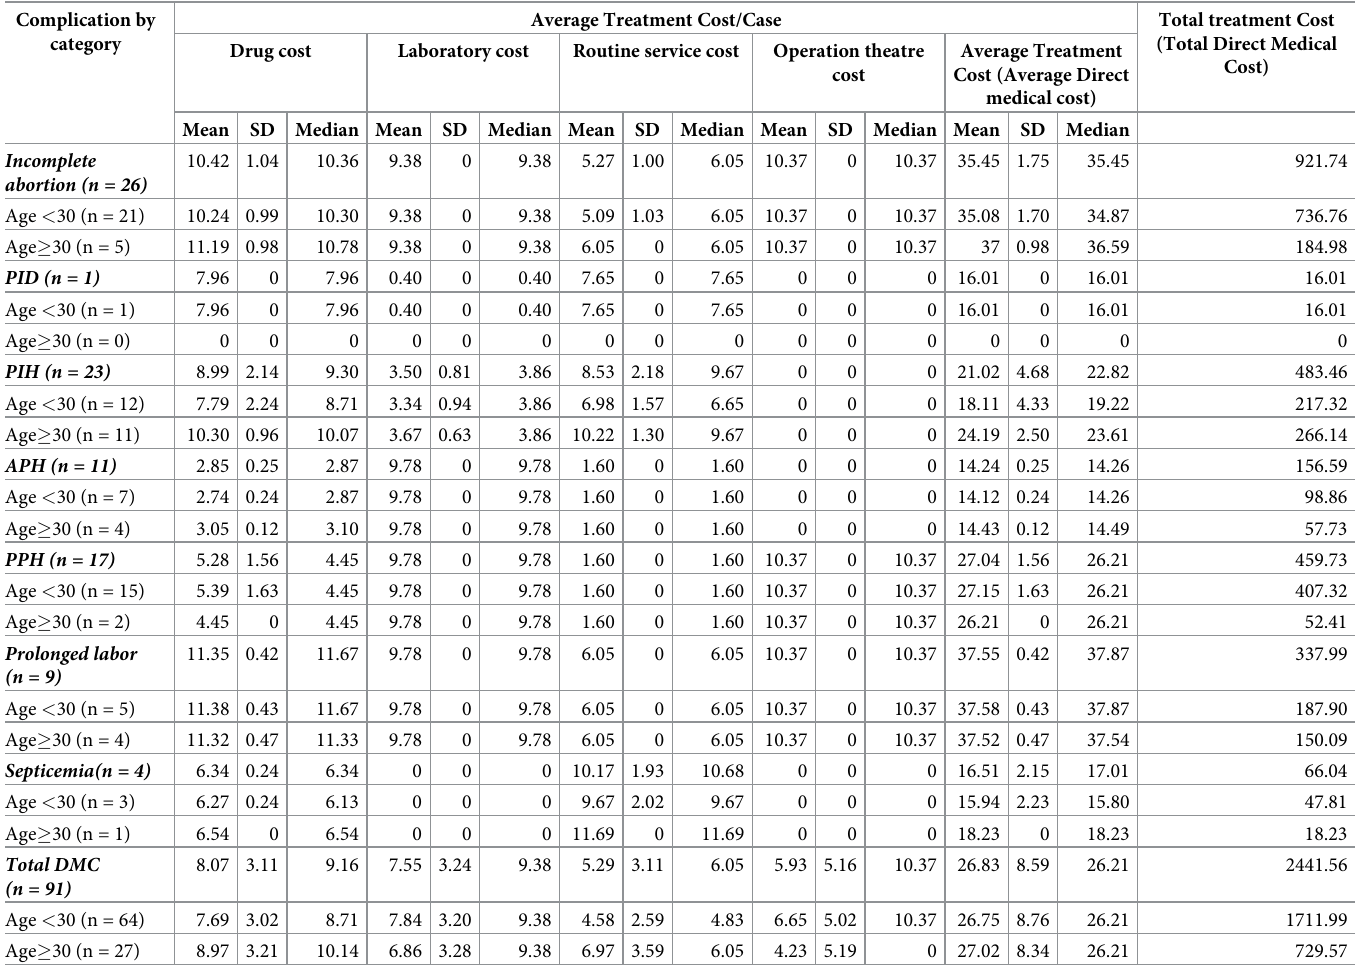
Table 3. Total and average direct medical cost by disease category (USD) (Mean ± SD, medium).